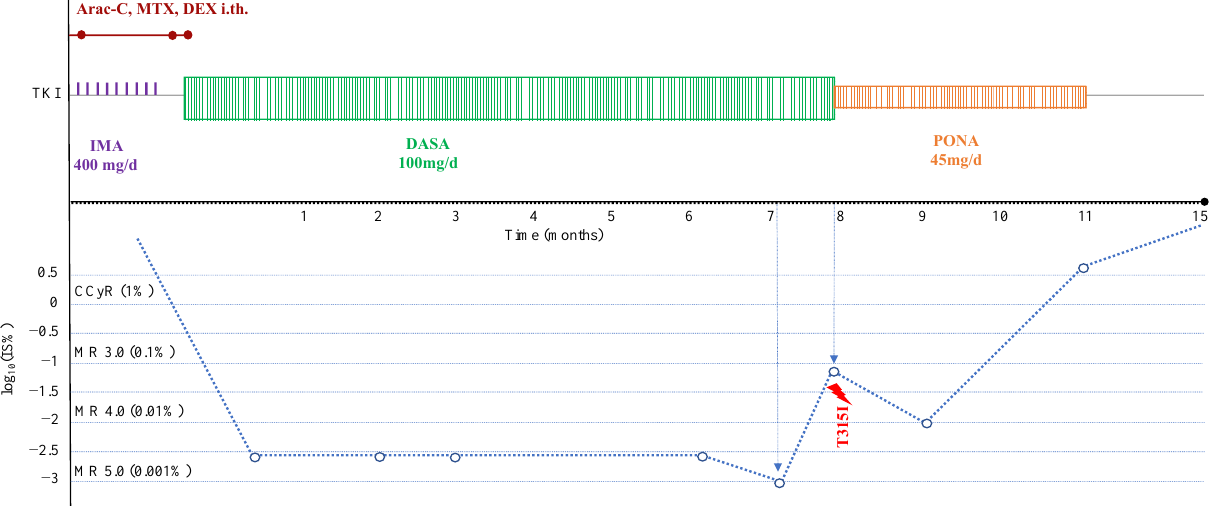
Figure 2. Clinical course of the blast crisis of Patient 2. Abbreviation: R-CVP, rituximab-cyclophosphamide, vincristine, prednisone; Ara-C, cytosine arabinosine; MTX, methotrexate; DEX, dexamethasone; i.th., intrathecal; IMA, imatinib; DASA, dasatinib; PONA, ponatinib; TKI, tyrosine kinase inhibitor; CCyR, complete cytogenetic response; MR, molecular response.